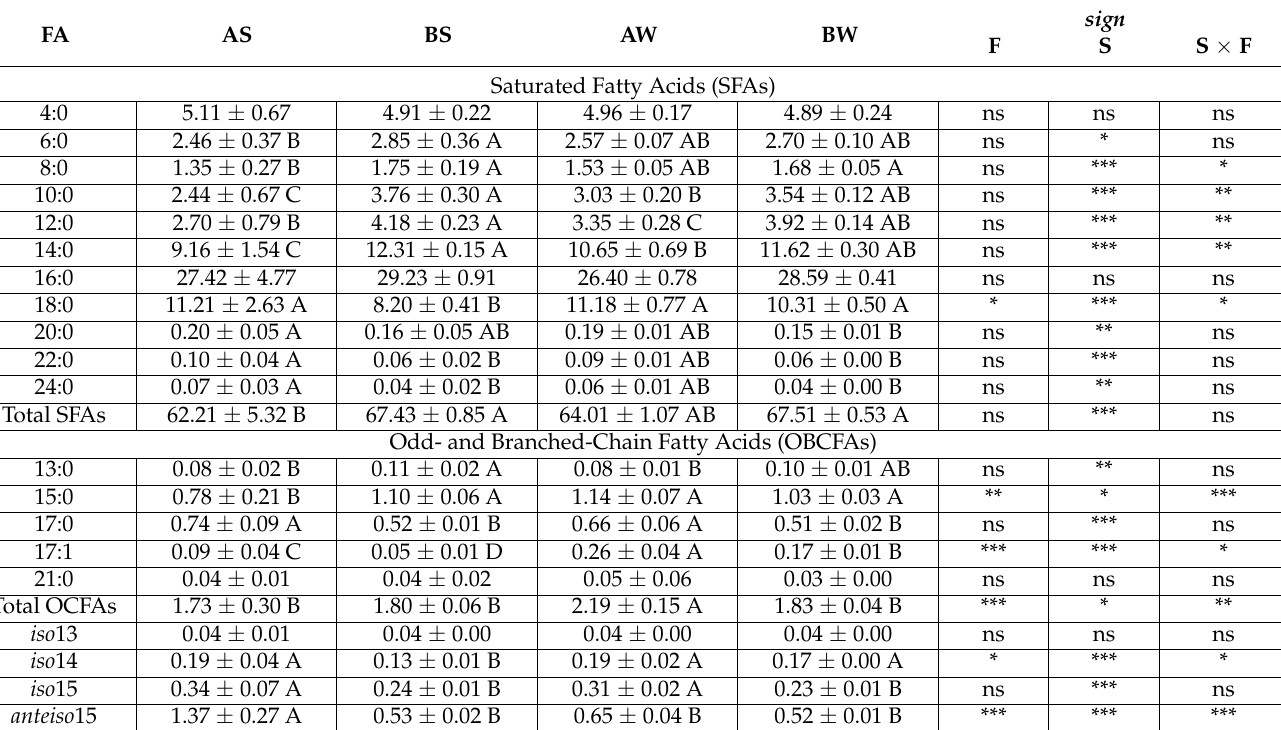
Table 3. FA composition (g/100 g of FA) of milk samples collected from farms A and B during summer and winter. Data are presented as mean ± standard deviation. AS—farm A summer